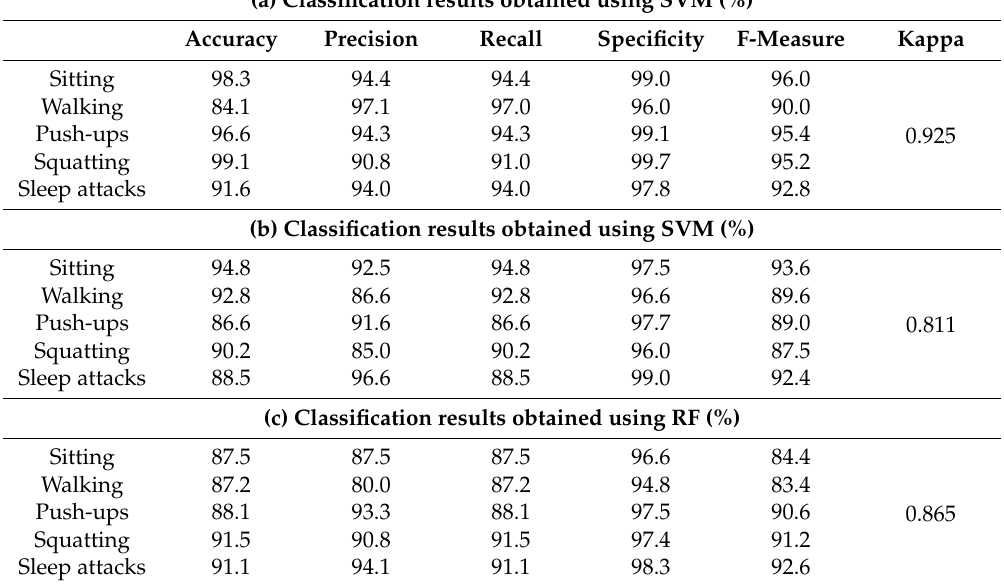
Table 5. Classification